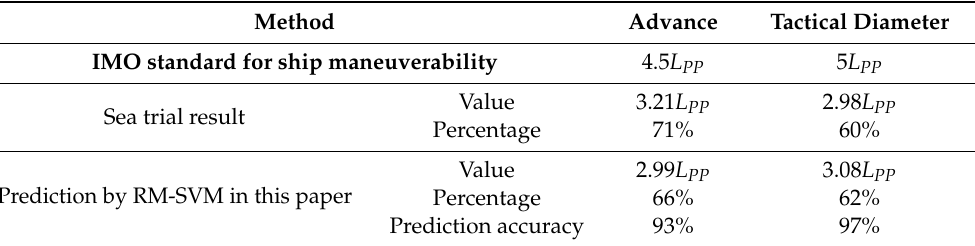
Table 4. Validation for − 35 ◦ turning circle test of Yukun full-scale ship and comparison with IMO